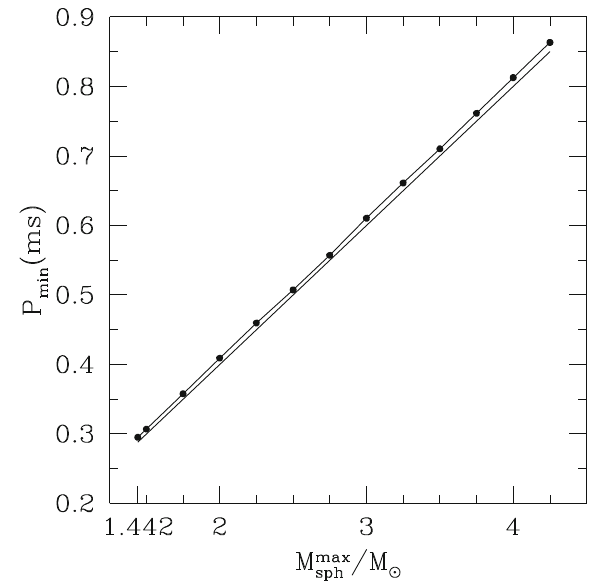
Fig. 4 Minimum period P min allowed by causality for uniformly rotating, relativistic stars as a function of the mass M max sph of the maximum mass nonrotating model. Lower curve: constructed using the absolute minimum-periodEOS(85),whichdoesnotmatchatlowdensitiestoaknownEOS.Uppercurve:constructed using the minimum-period EOS (92), which matches at low densities to the FPS EOS. Due to the causality constraint, the region below the curves is inaccessible to stars. (Image reproduced with permission